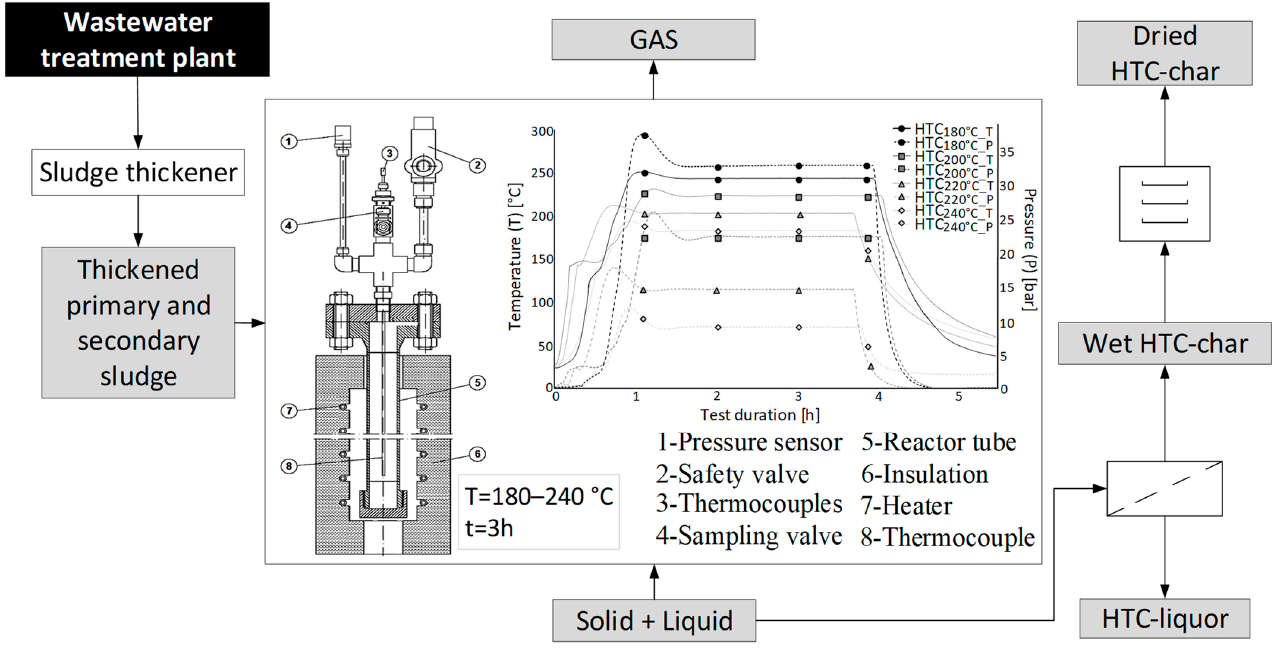
Figure 1. HTC experimental unit.